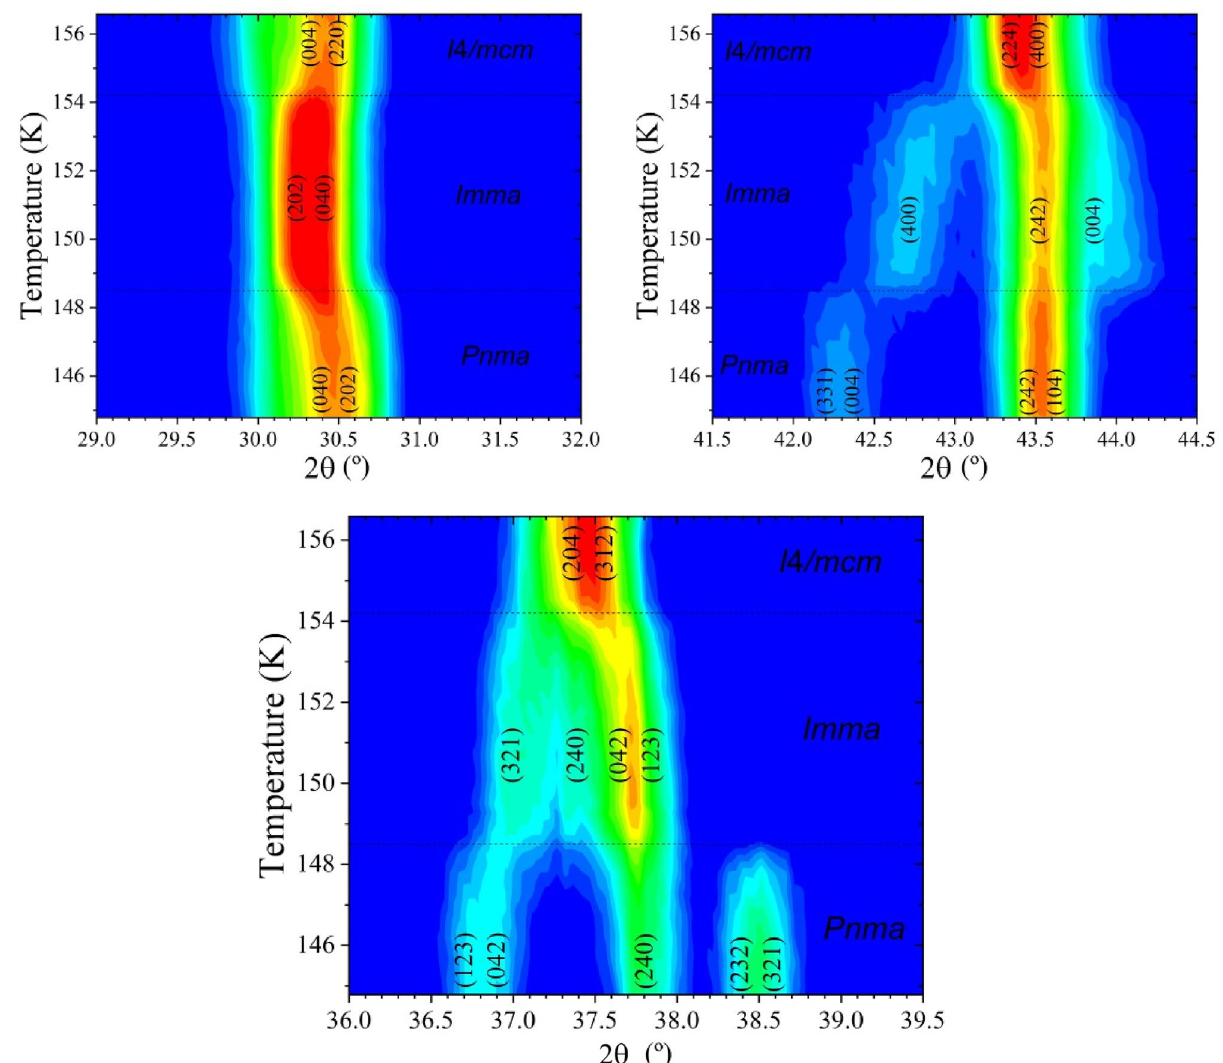
Figure 9. 2D maps showing the evolution of three selected NPD angular regions within the 135–156 K temperature range, highlighting the Pnma-Imma-P4/mmm phase transitions for MAPbBr 3